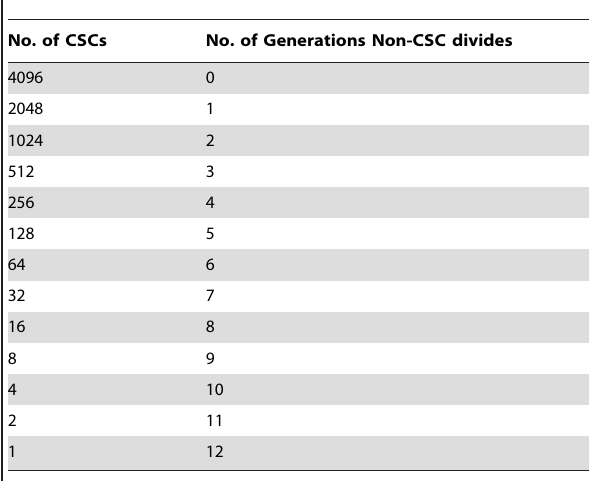
Table 1. The maximum number of generations that non- CSCs divide when there is a maximum of 8,192 cells per